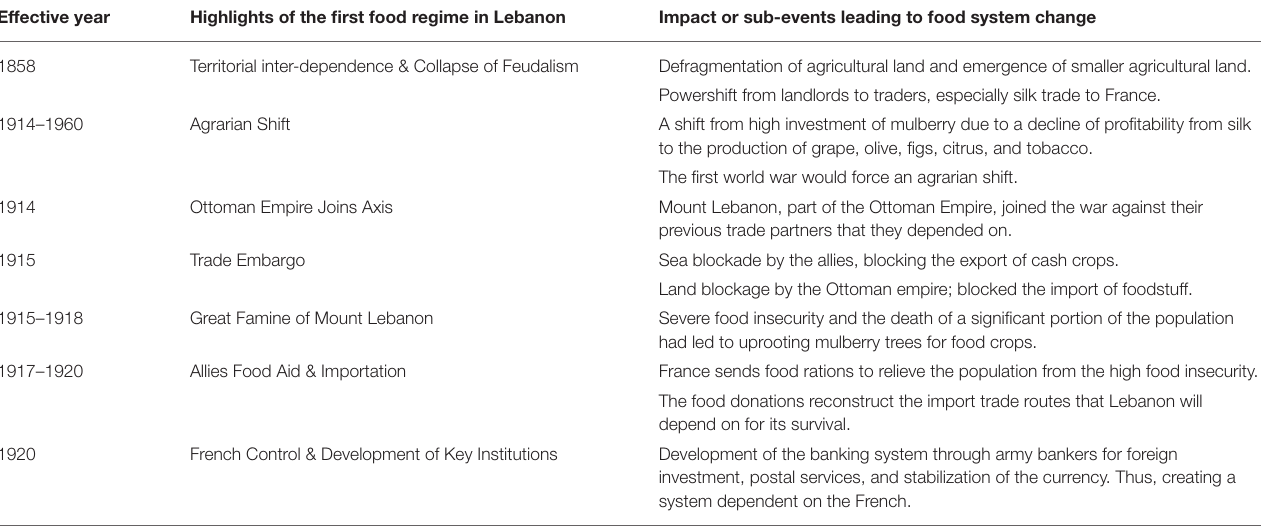
TABLE 1 | Overview of the first food regime in